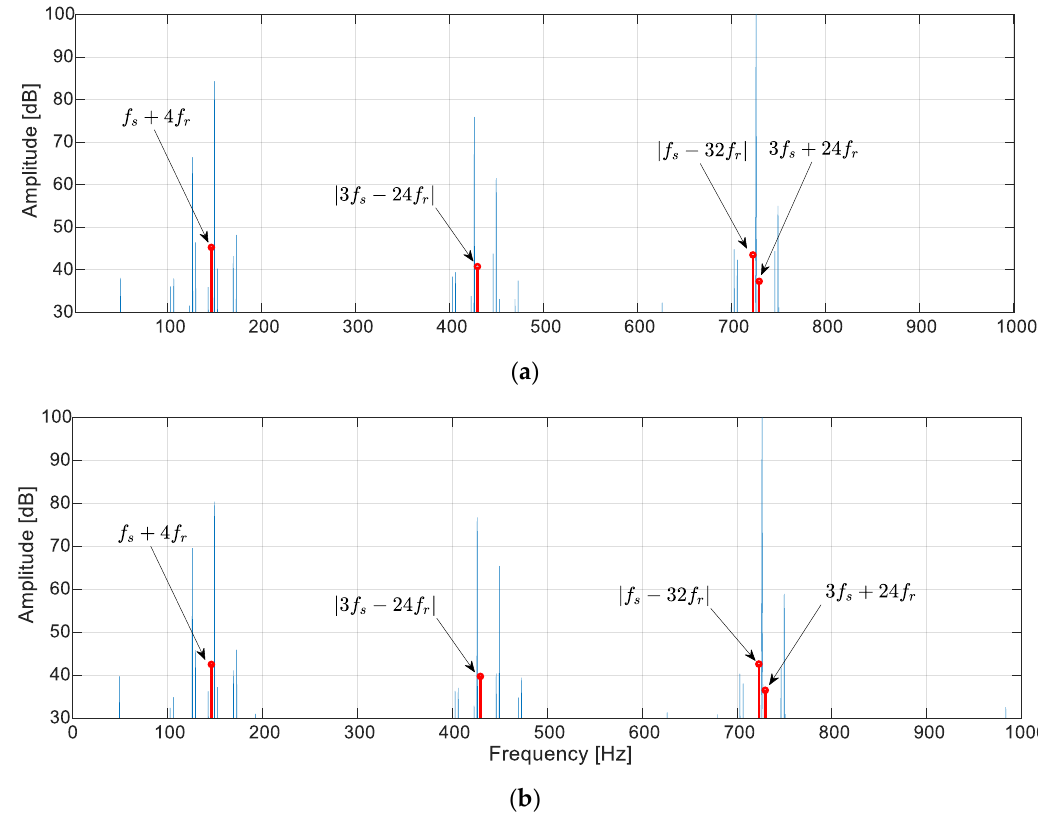
Figure 10. ZSC spectrum of the motor with dynamic eccentricity for the stator winding connection: ( a ) delta connection; ( b ) wye connection with neutral